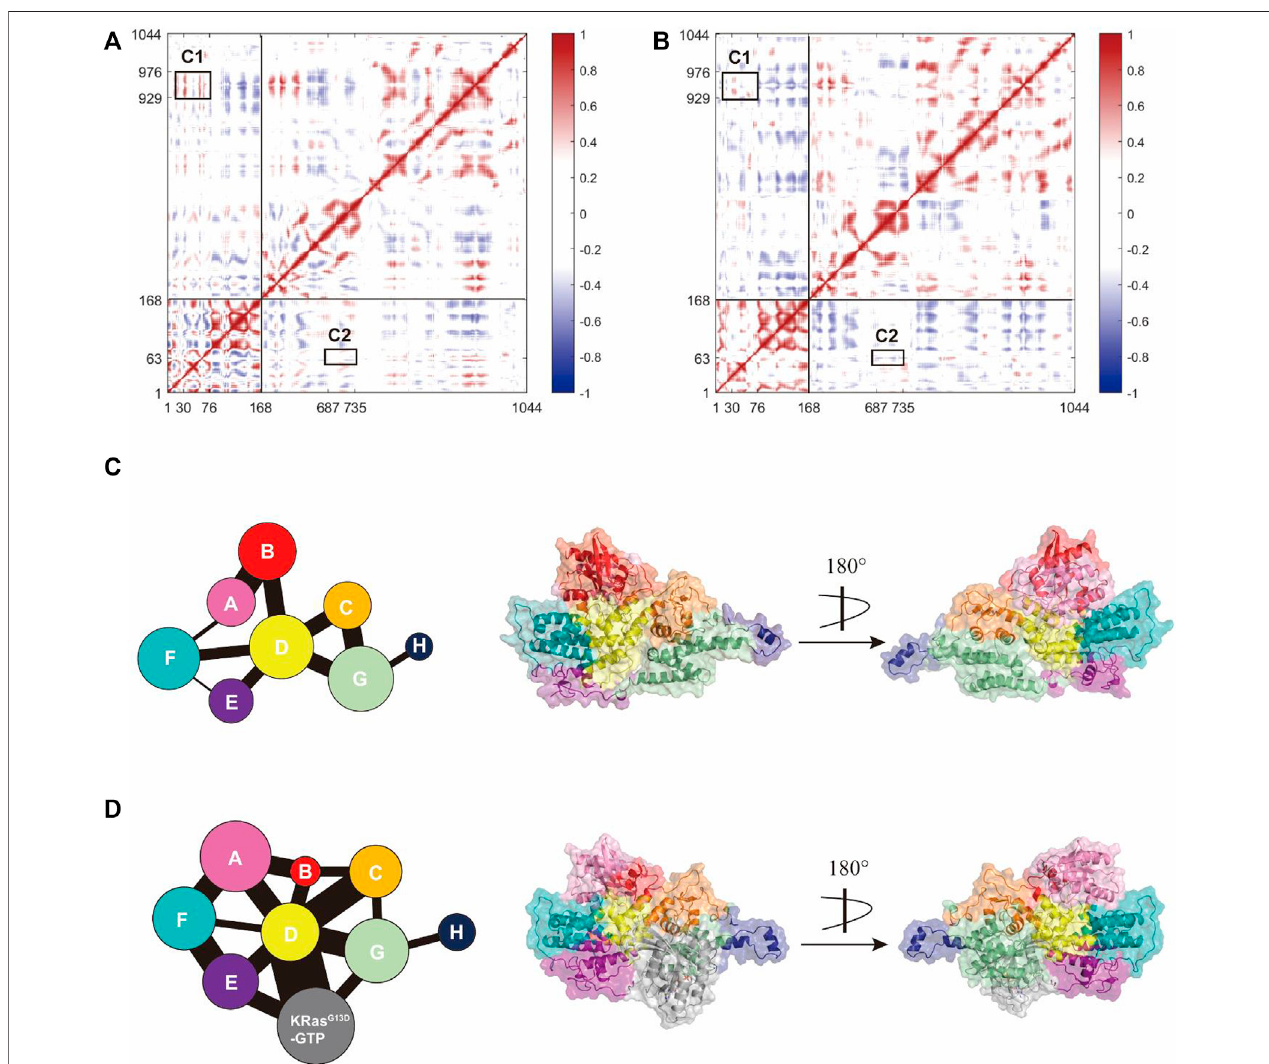
FIGURE 6 | K-Ras4B G13D and SOS cat allosteric interactions. The dynamic cross-correlation matrix of the binary (A) and ternary (B) systems. Positive regions (red) representcorrelatedmotions,whereasnegativeregions(blue)representanticorrelatedmotions.C1showscorrelationsofthehelicalhairpindomainwiththeswitchIand (cid:129) switchIIregion,andC2showsanticorrelatedmovementoftheswitchIIwiththeSOS cat K-Ras4B G13D – GTPinterfaceresidues.Correlatedmotionswithabsolutevalues < 0.3 were neglected and shown in white. Map of the community network in the binary (C) and ternary (D) systems. Areas of the circles represent the numbers of residues in corresponding communities and the widths of sticks connecting communities represent the intercommunity